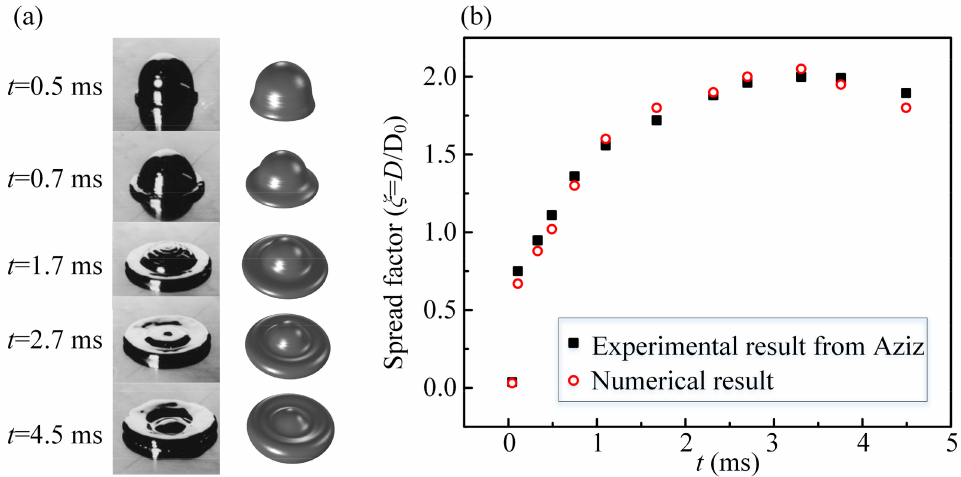
Figure 2. Comparison with experimental results of Aziz [25]: ( a ) Evolution of the impacting process (Reprinted with permission from Ref. [25]. Copyright 2000 Elsevier) and ( b ) spreading factor.